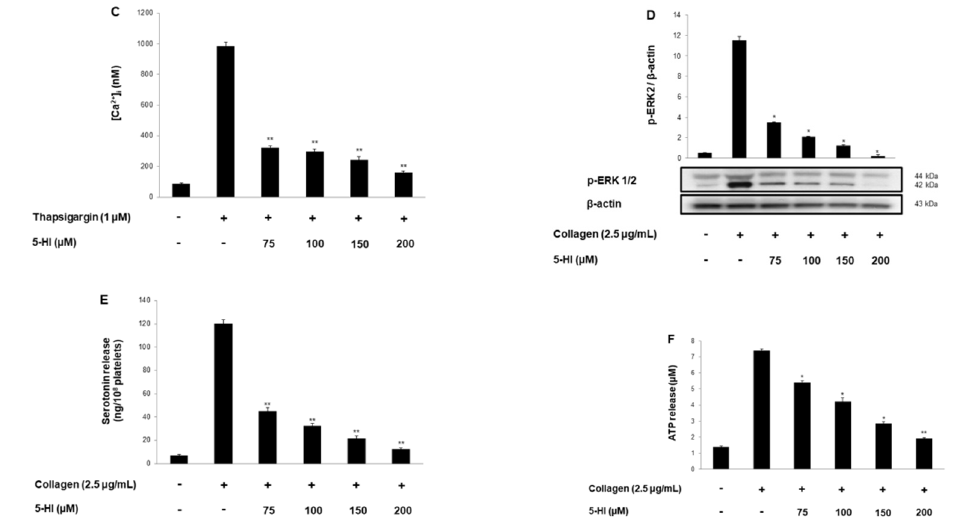
Figure 2. Effect of 5-HI on [Ca 2 + ] i mobilization, Ca 2+ influx, IP 3 RI and ERK phosphorylation, and serotonin and ATP release. ( A ) Effect of 5-HI’s effect on collagen-induced [Ca 2+ ] i mobilization. ( B ) 5-HI’s effect on thapsigargin-induced Ca 2+ influx. ( C ) 5-HI’s effect on collagen-induced IP 3 RI phosphorylation. ( D ) 5-HI’s effect on collagen-induced ERK phosphorylation. ( E ) 5-HI’s effect on serotonin release. ( F ) 5-HI’s effect on ATP release. All experiments were performed as described in “Materials and Methods” section. The data are expressed as the mean ± standard deviation (n = 4). * p < 0.05, ** p < 0.01 versus the collagen-stimulated human platelets.